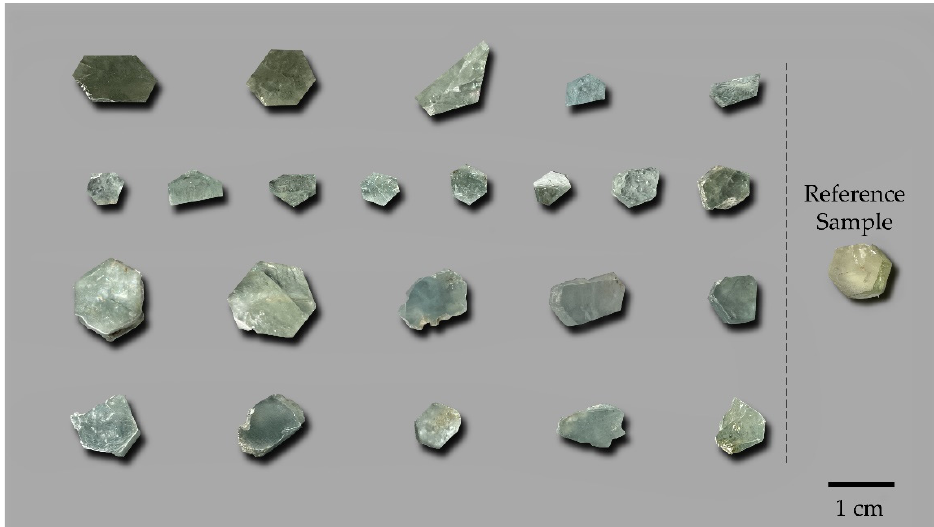
Figure 1. Images of 23 cylindrical beryl samples. The experimental samples, which are blue-green, are on the left of the dotted line, and the reference sample, which is yellow, is on the right of the dotted line.